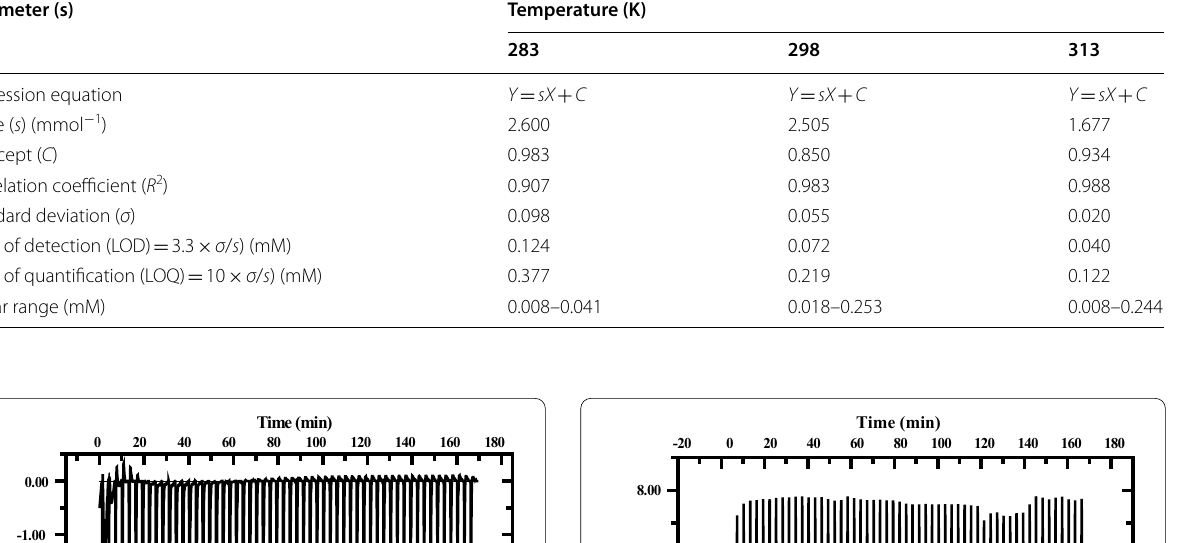
ion at different temperature ¯